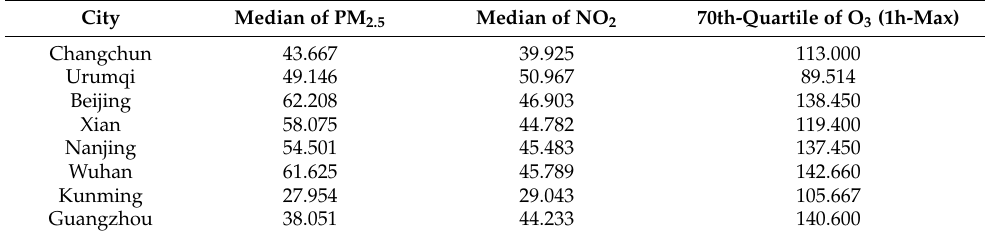
Table 1. The cut-off of PM 2.5 , NO 2 , and O 3 in each city ( µ g/m 3 ). City